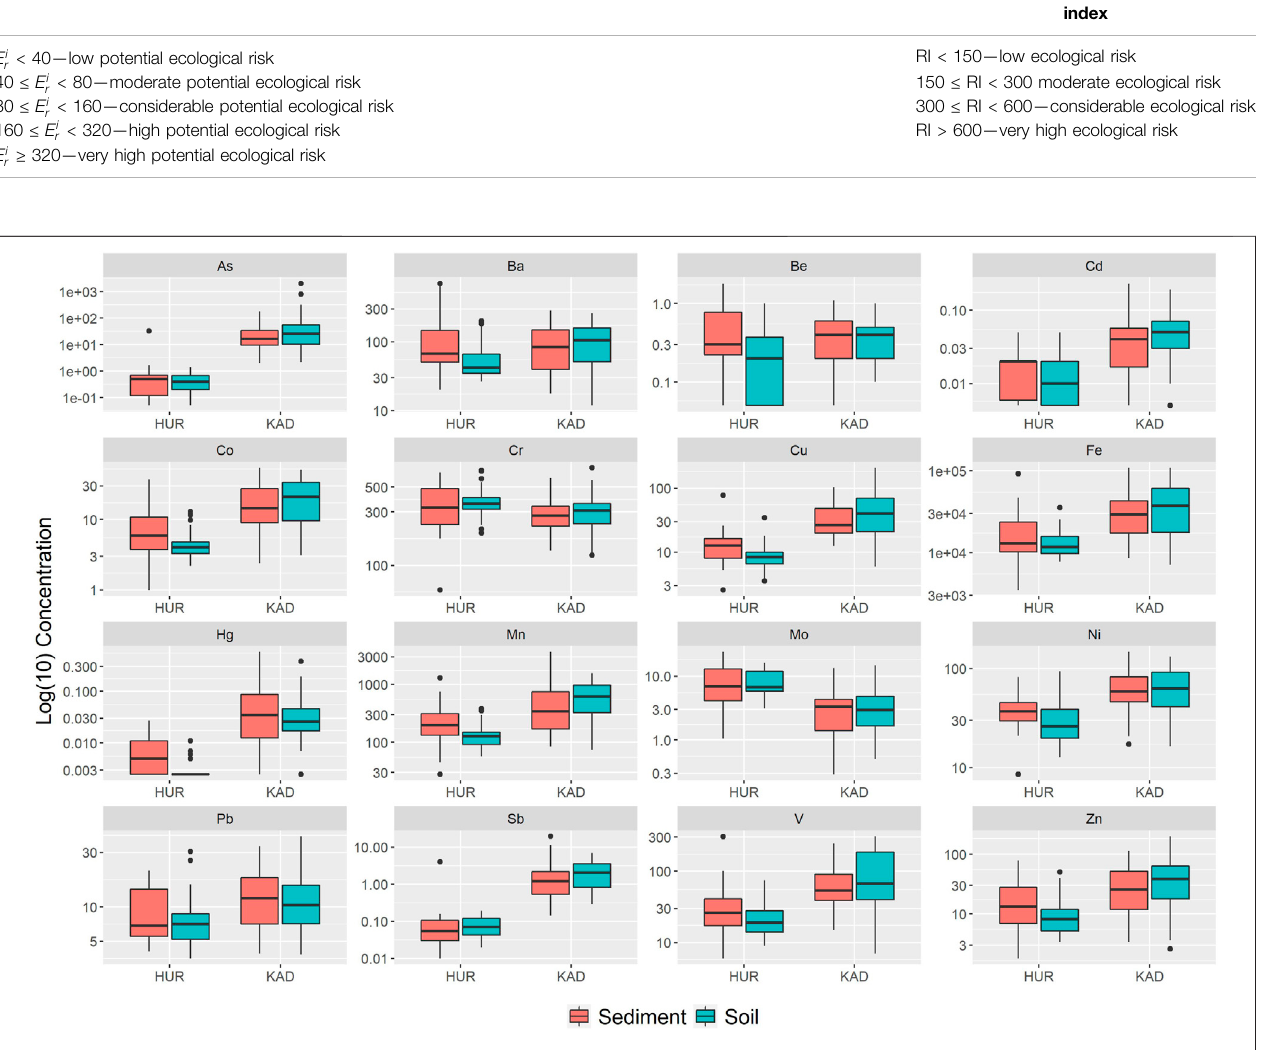
Classi fi cation thresholds indicated on the boxplots are the upper boundaries of the “ Uncontaminated ” , “ Considerably contaminated ” and “ Extremely contaminated ” classes.